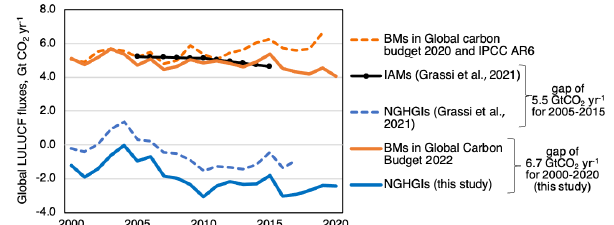
Figure 4. Global land-use CO 2 fluxes from recent studies: BMs in the Global Carbon Budget 2020 (Friedlingstein et al., 2020) and in the IPCC Sixth Assessment Report (IPCC, 2022); integrated as- sessment models (IAMs) and NGHGIs in Grassi et al. (2021); BMs in the Global Carbon Budget 2022 (Friedlingstein et al., 2022) and NGHGIs in Grassi et al. (2022) updated for the DRC in this study. On the right, the gaps between global models and NGHGIs esti- mated by Grassi et al. (2021) (for the period 2005–2015) and by this study (for 2000–2020) are shown.